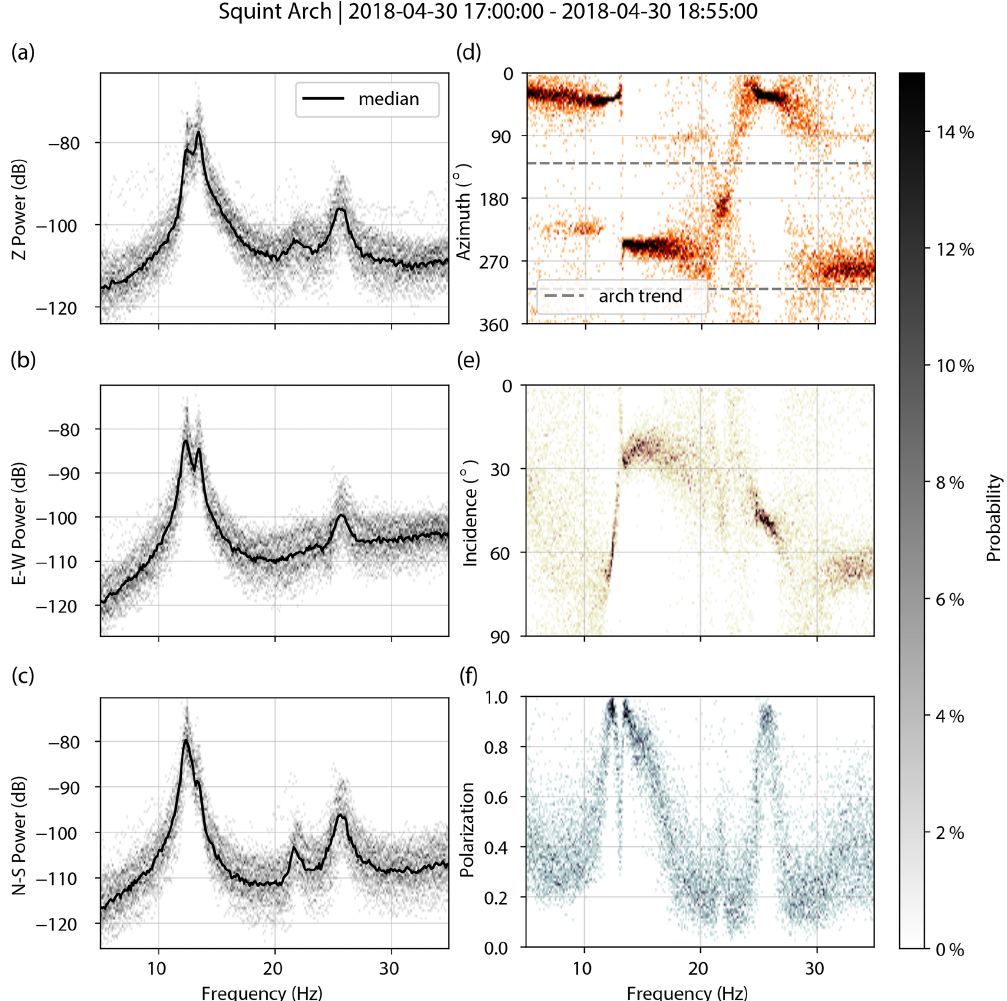
Figure A6. Squint Arch. PSDs for vertical (a) , east–west (b) , and north–south (c) components. Decibel powers are relative to 1m 2 s − 4 Hz − 1 . Polarization attributes of azimuth (d) , incidence (e) , and degree of polarization (f) .